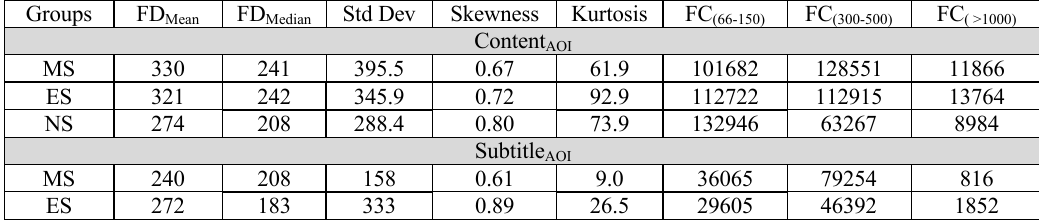
Table 2. Descriptive statistics for the three groups (MS - Marathi subtitle; ES - English subtitle and NS - No subtitle) and two areas of interest (AOI) – content and subtitle. FD stands for fixation duration in milliseconds. FC stands for fixation counts and the subscripts refer to the range in milliseconds. Kurtosis and Pearson’s coefficient of skewness are also reported.